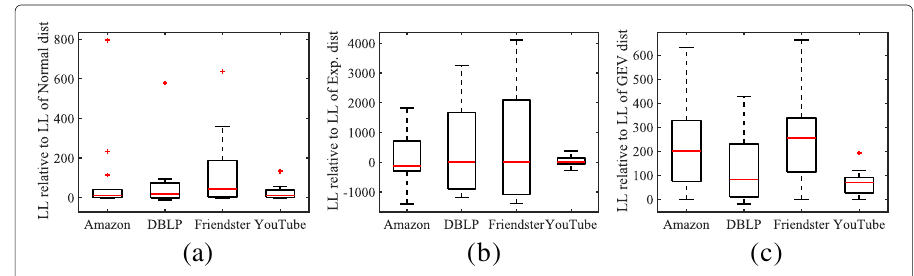
Fig. 2 Relative log-likelihoods (LL) of the hypothesised distributions compared to the other distributions. For each dataset, the boxplot indicates how well each parameter follows the hypothesised distribution compared to other potential distributions. Positive values indicate that the preferred distribution performs better than the others and zero indicates even performance. a γ b H c